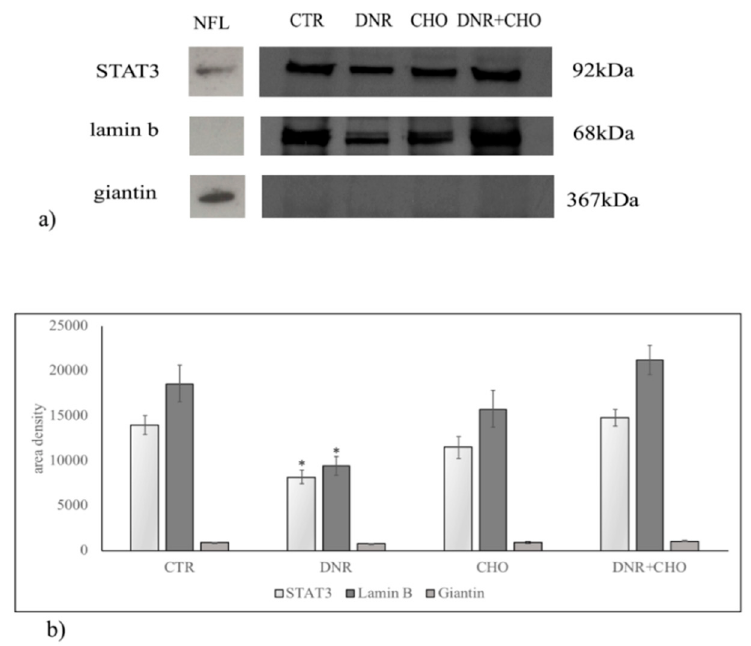
Figure 3. Immunoblotting analysis of nSMase, STAT3, lamin b, and giantin in nuclear lipid microdomains. For comparison, on the left, are the proteins present in nuclei free-lysates (NFL) prepared from control sample. Cells were treated with 1 µ M DNR or 800 nM CHO or 1 µ M DNR + 800 nM CHO. ( a ) The position of the 92 kDa for STAT3, 68 kDa for lamin b and 367 kDa for giantin was evaluated in relation to the position of molecular size standards; ( b ) the area density was quantified by densitometry scanning and analysis with Scion Image. Data represent the mean ± SD of six independent experiments. * p < 0.05.